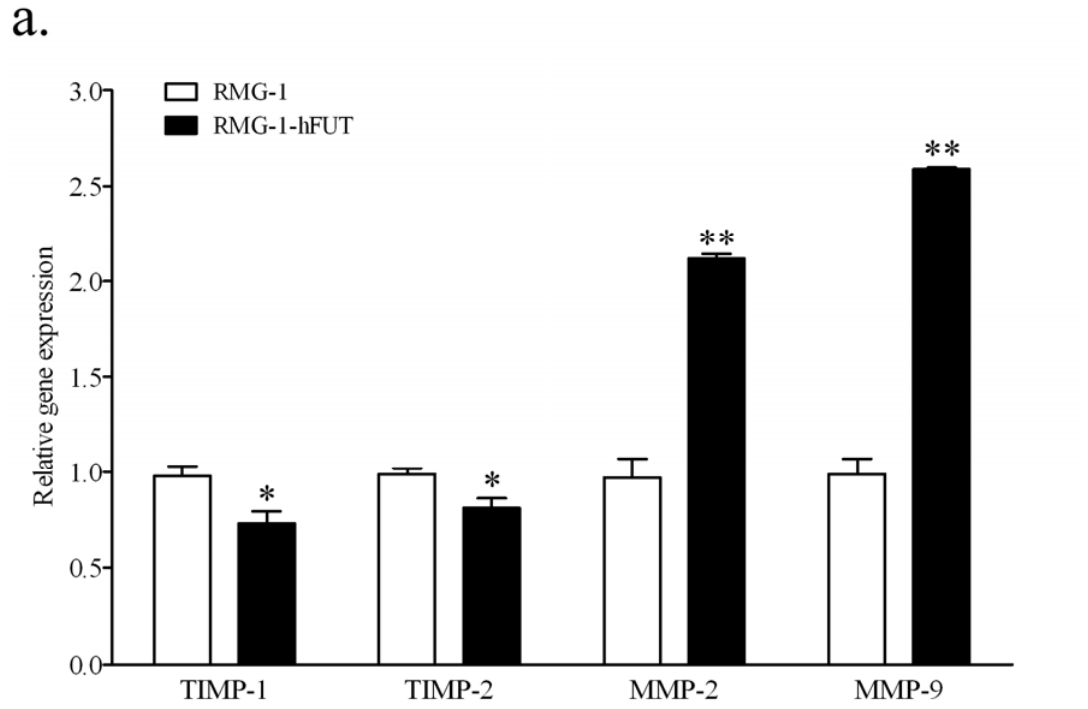
Figure 2. Expression of MMP-2, MMP-9, TIMP-1 and TIMP-2 in RMG-1 and RMG-1-hFUT cells shown by quantitative Real-Time RT-PCR ( a ) and Western blot analysis ( b ). ( a ) According to quantitative Real-Time RT-PCR, the mRNA level of these two TIMPs was significantly reduced, but the mRNA level of the two MMPs was markedly increased in RMG-1-hFUT cells, compared with RMG-1 cells ( b ) Protein levels of MMP-2, MMP-9, TIMP-1 and TIMP-2, determined by Western blot, were consistent with the mRNA levels. Representative blots are shown, and protein size is expressed in kDa. * P < 0.05, ** P <